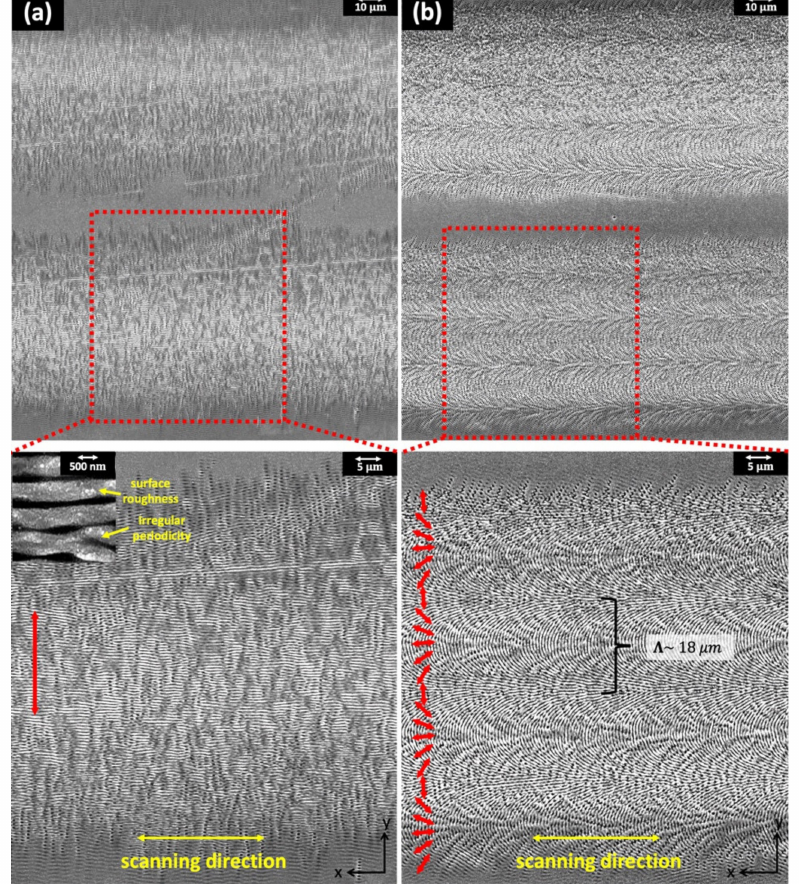
Figure 3. SEM images of ( a ) UD-LSFLs and ( b ) OD-LSFLs fabricated at a defocused distance of 1.5 mm. Double-headed red arrows indicate the grating vector (orientation) of UD- and OD-LSFLs and the polarization direction of fs laser pulses. The inset in ( a ) shows the surface roughness and irregular periodicity of UD-LSFLs on